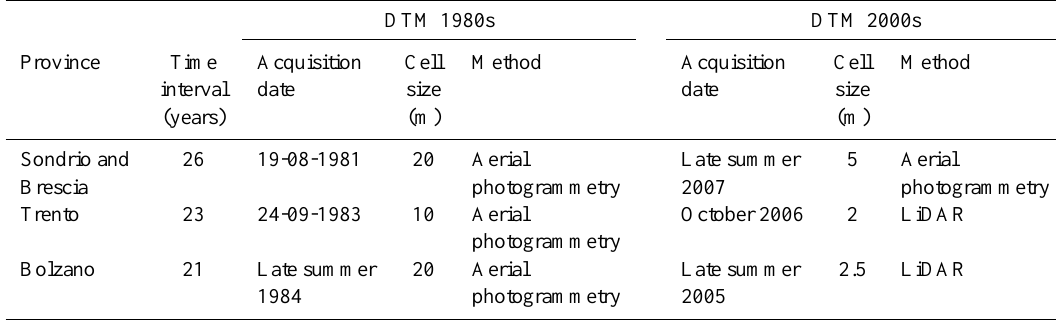
Table 1. Characteristics of the digital terrain models available for the Ortles-Cevedale